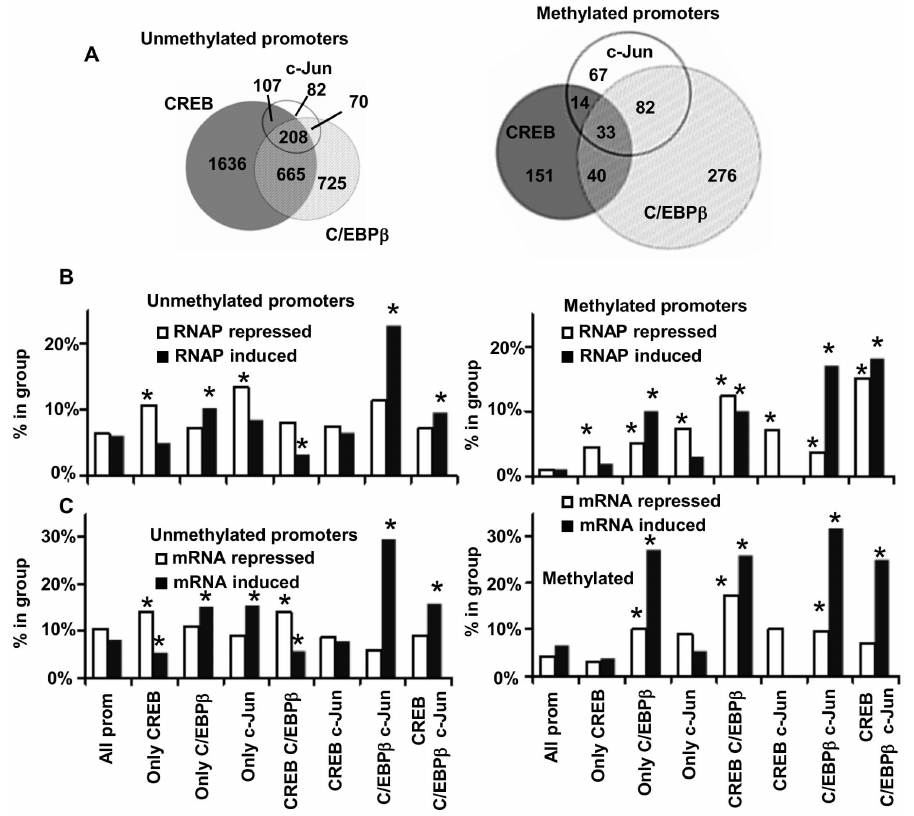
Figure 5. C/EBP b preferentially binds to methylated promoters and methylated promoters bound by C/EBP b are preferentially induced by differentiation. A. Euler diagrams of methylated and unmethylated promoters bound by different combination of transcription factors show that CREB binding is depleted on methylated promoters while C/EBP b and c-Jun binding is overrepresented. B. Percent of promoters with RNAP is induced or repressed by differentiation in promoters bound by different combinations of transcription factors in differentiated keratinocytes for unmethylated (left) and methylated promoters (right). C. Percent of genes with mRNA is induced or repressed by differentiation in promoters bound by different combinations of transcription factors in differentiated keratinocytes for unmethylated (left) and methylated promoters (right). * - numbers are significantly different from expected, (p , 0.05).